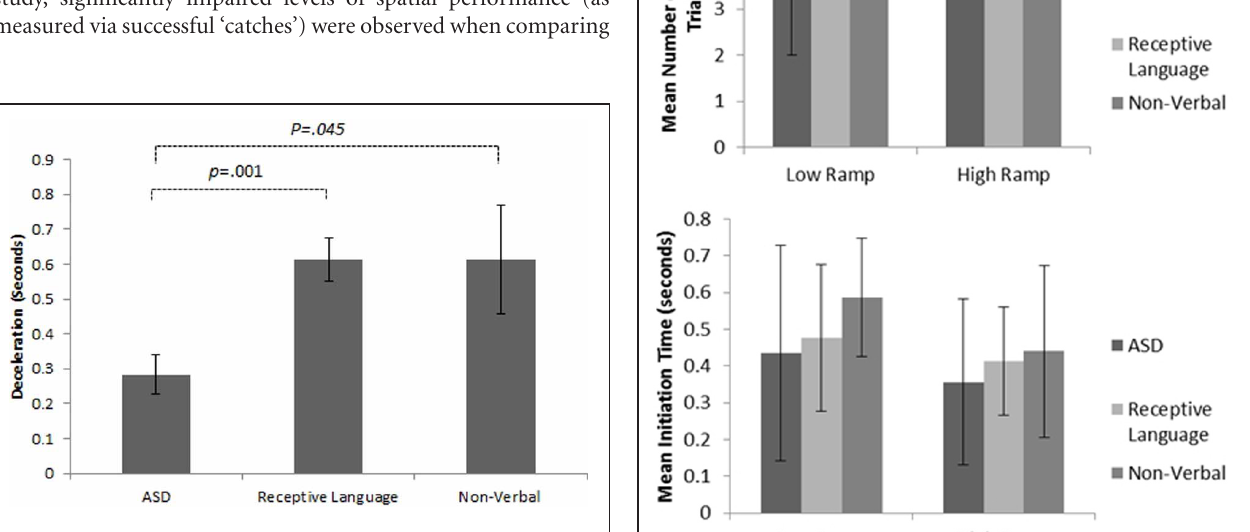
FIGURE 3 | Example summary graph for deceleration patterns when approaching a single comer section of the track task. Combined analysis of performance on all comer sections highlights significantly shorter phases of deceleration in the ASD group than both the receptive language ( p < 0 . 05) and non-verbal ( p < 01) control groups .